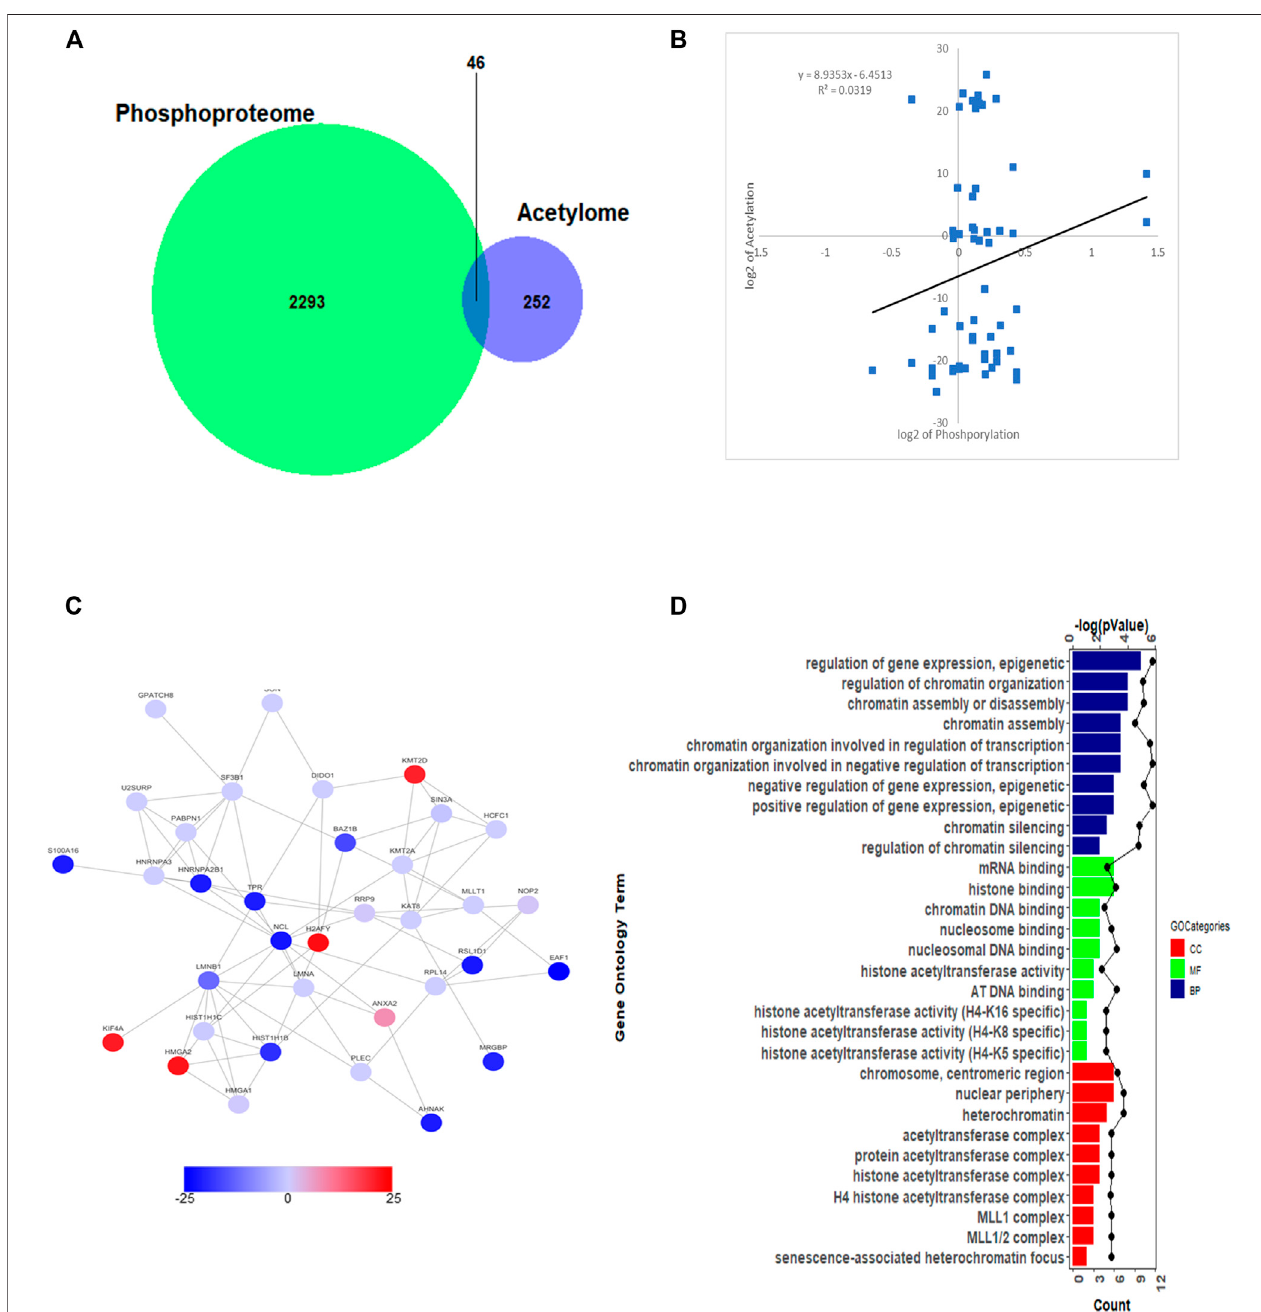
FIGURE 6 | Crosstalk analysis between phosphoproteome and acetylome. (A) Overlap of total proteins between acetylome and phosphoproteome. (B) Correlationbetweenacetylomeandphosphoproteome. (C) Protein – proteininteractionnetworkbetweenacetylomeandphosphoproteome. (D) GOenrichmentanalysis between acetylome and